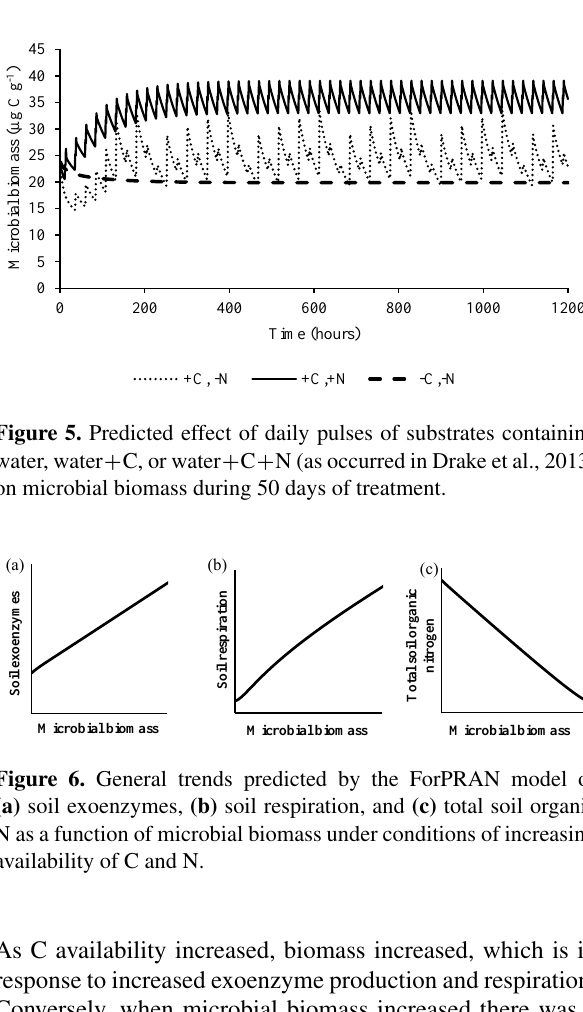
Figure 4. Regression of microbial biomass observed by Drake et al. (2013) against ForPRAN results. Regression parameters were not significantly different from 1 (slope) and 0 (intercept), respec- tively. The Nash–Sutcliffe efficiency (NSE), mean error (ME), mean absolute error (MAE), and root mean square error to standard devi- ation ratio (RSR) are indicators of model efficiency and bias.